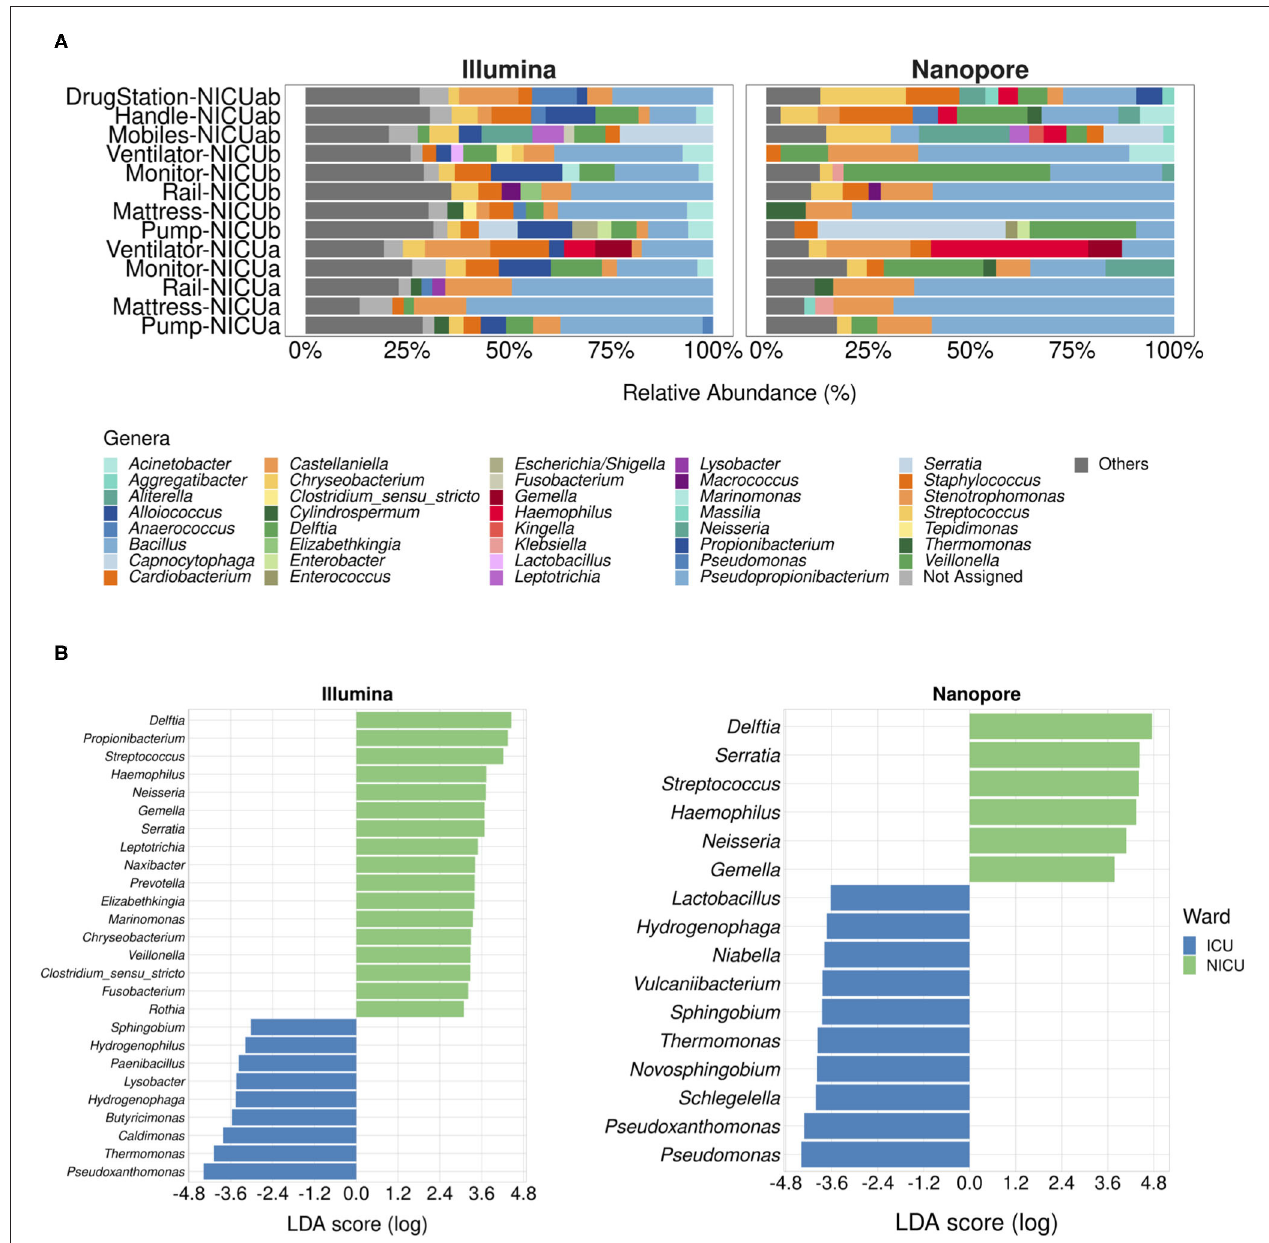
FIGURE 2 | Neonatal Intensive Care Units microbial profiles obtained with Illumina and nanopore sequencing. (A) Stacked bar plots depicting main genera detected in NICU samples using both methodologies. Genera with relative abundances below 2.5% were grouped under the label “Others.” (B) Ward-specific taxonomic biomarkers for (N)ICU detected with linear discriminant analysis effect size (LEfSe). Statistical significance was defined as p <